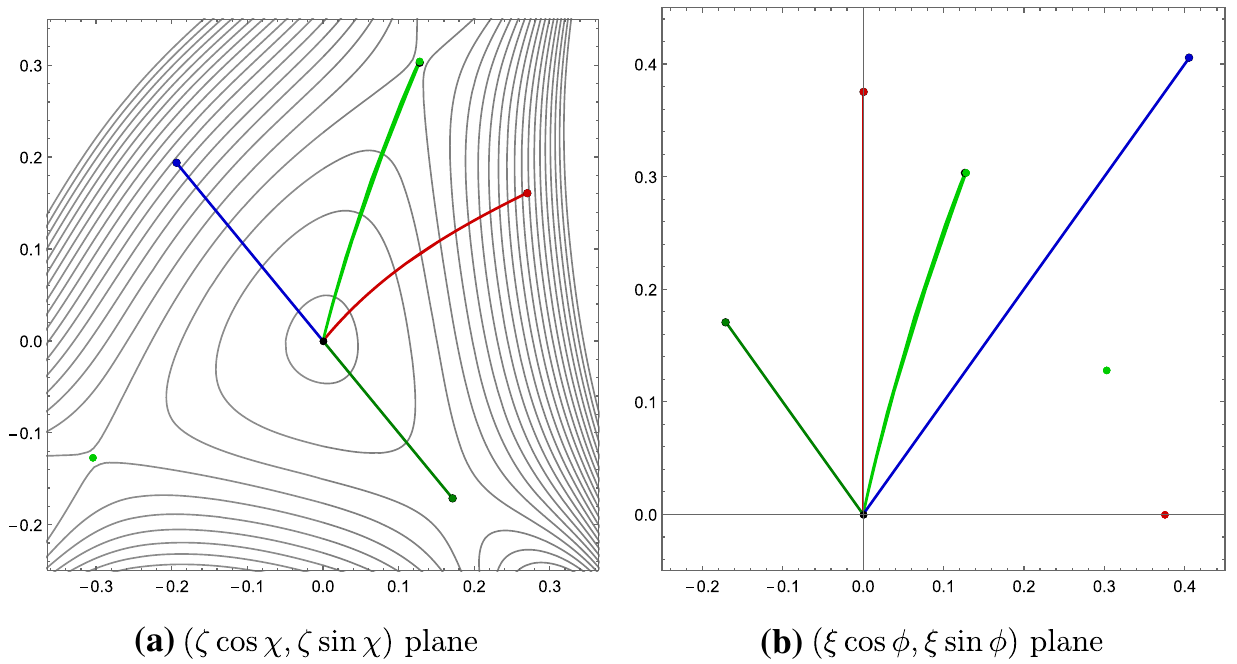
are shown on the contour plot of the 8